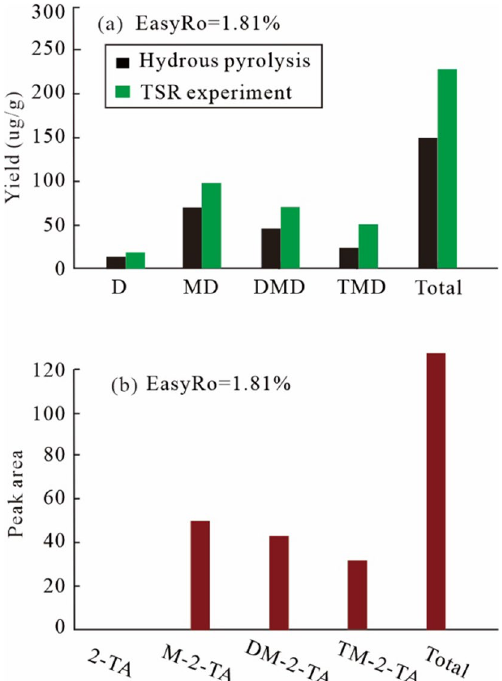
Figure 12. Different types of diamantanes and thiaadmantanes hydrocarbons at 1.81% EasyRo: (a) variation in the yields (µg/g oil) of different types of diamantanes from hydrous pyrolysis, anhydrous pyrolysis, and